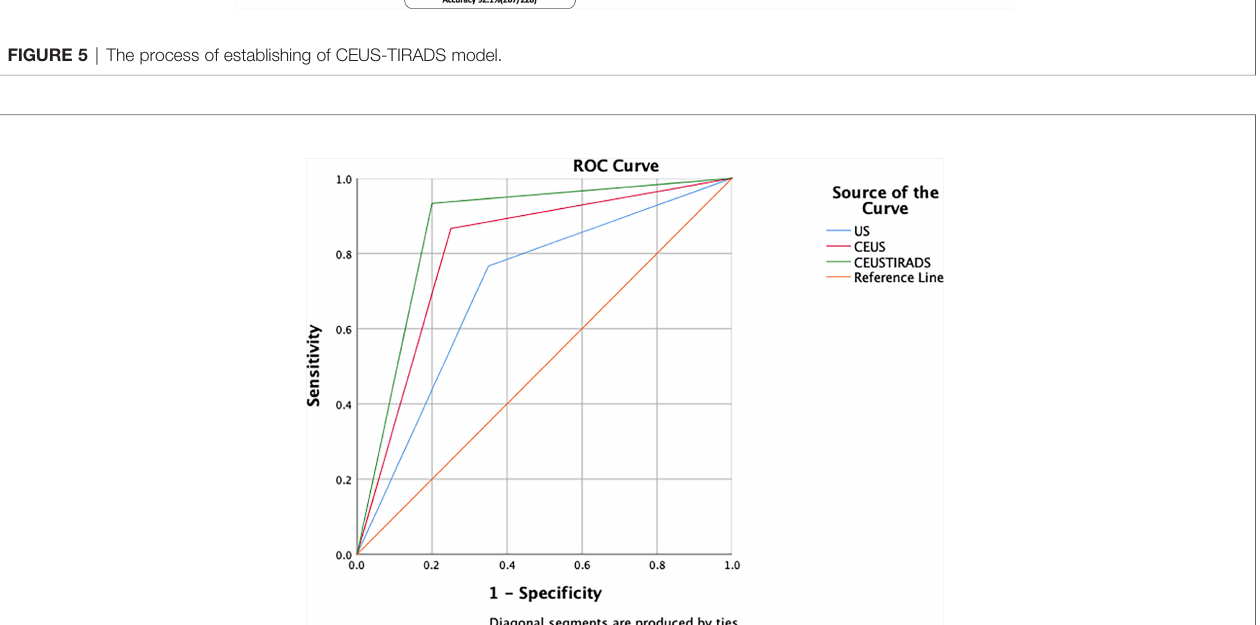
FIGURE 6 | The ROC curves of C-TIRADS, CEUS, and CEUS-TIRADS of 100 nodules in the validation cohort.